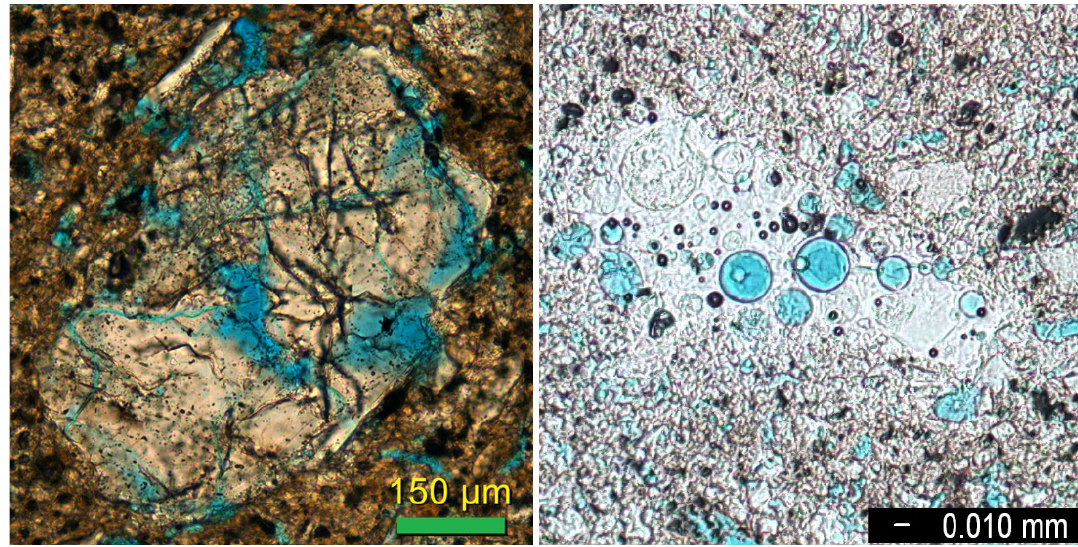
Figure 19. At lower firing temperatures ( left ), minerals such as quartz begin to melt, creating many connected intragranular pores. At higher temperatures ( right ), more grains will completely vitrify, leaving more isolated pores. Both are transmitted plane polarized light, with pores blue.